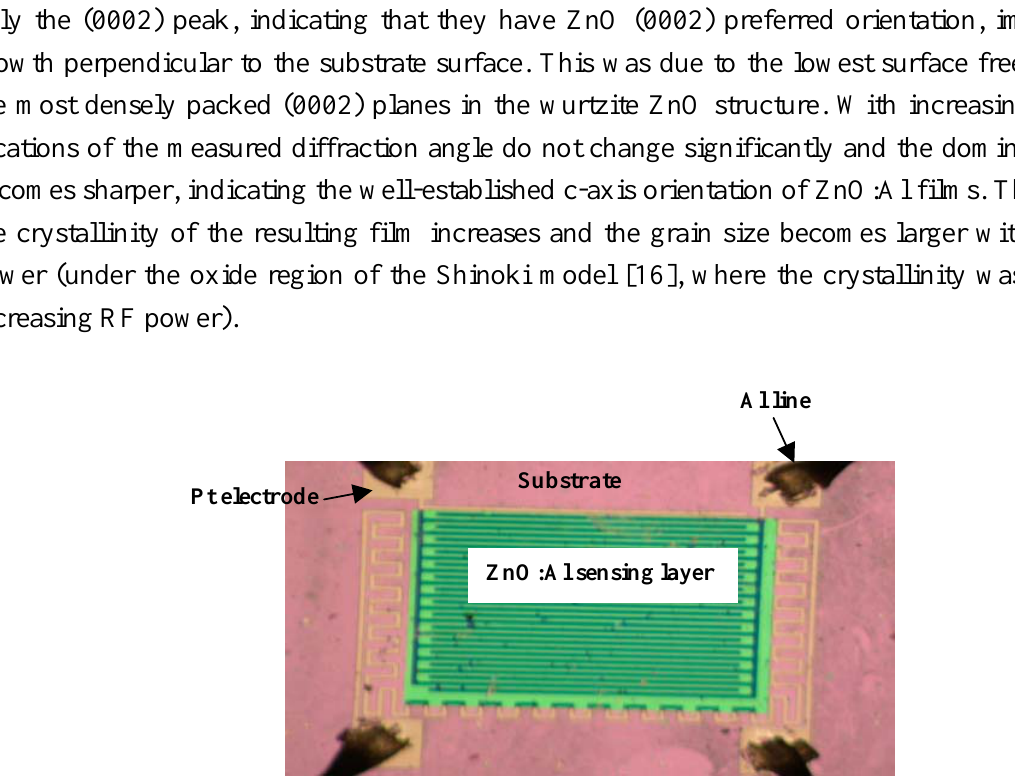
Figure 1. The sensor configuration